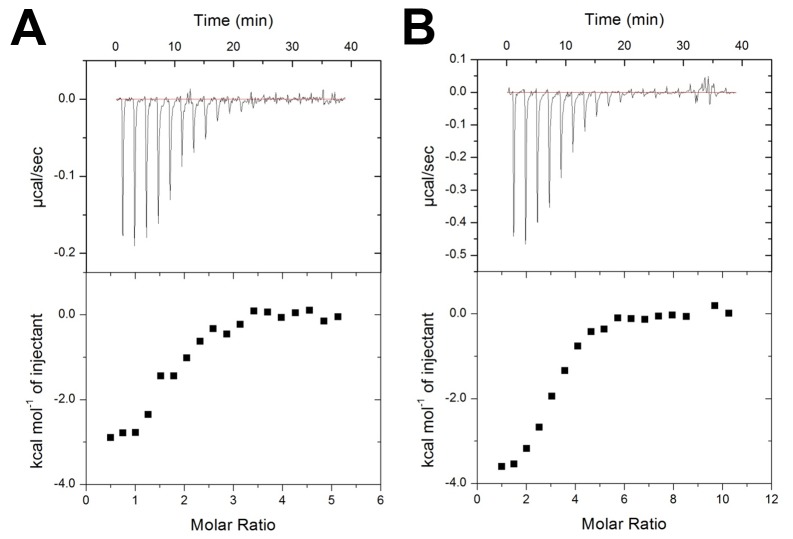
Isothermal titration of wild type/mutant ECP with Hep6.Raw ITC data of binding affinities between Hep6 and (A) wtECP and (B) double mutant ECP Q40A/H64A. Top panel: nineteen injections of Hep6 solution were titrated into protein in ITC cell. The area of each injection peak corresponded to the total heat released form that injection. Bottom panel: binding isotherm for heparin interaction with wtECP/double mutant ECP (Q40A/H64A), the integrated heat was plotted against the stoichiometry of 10.